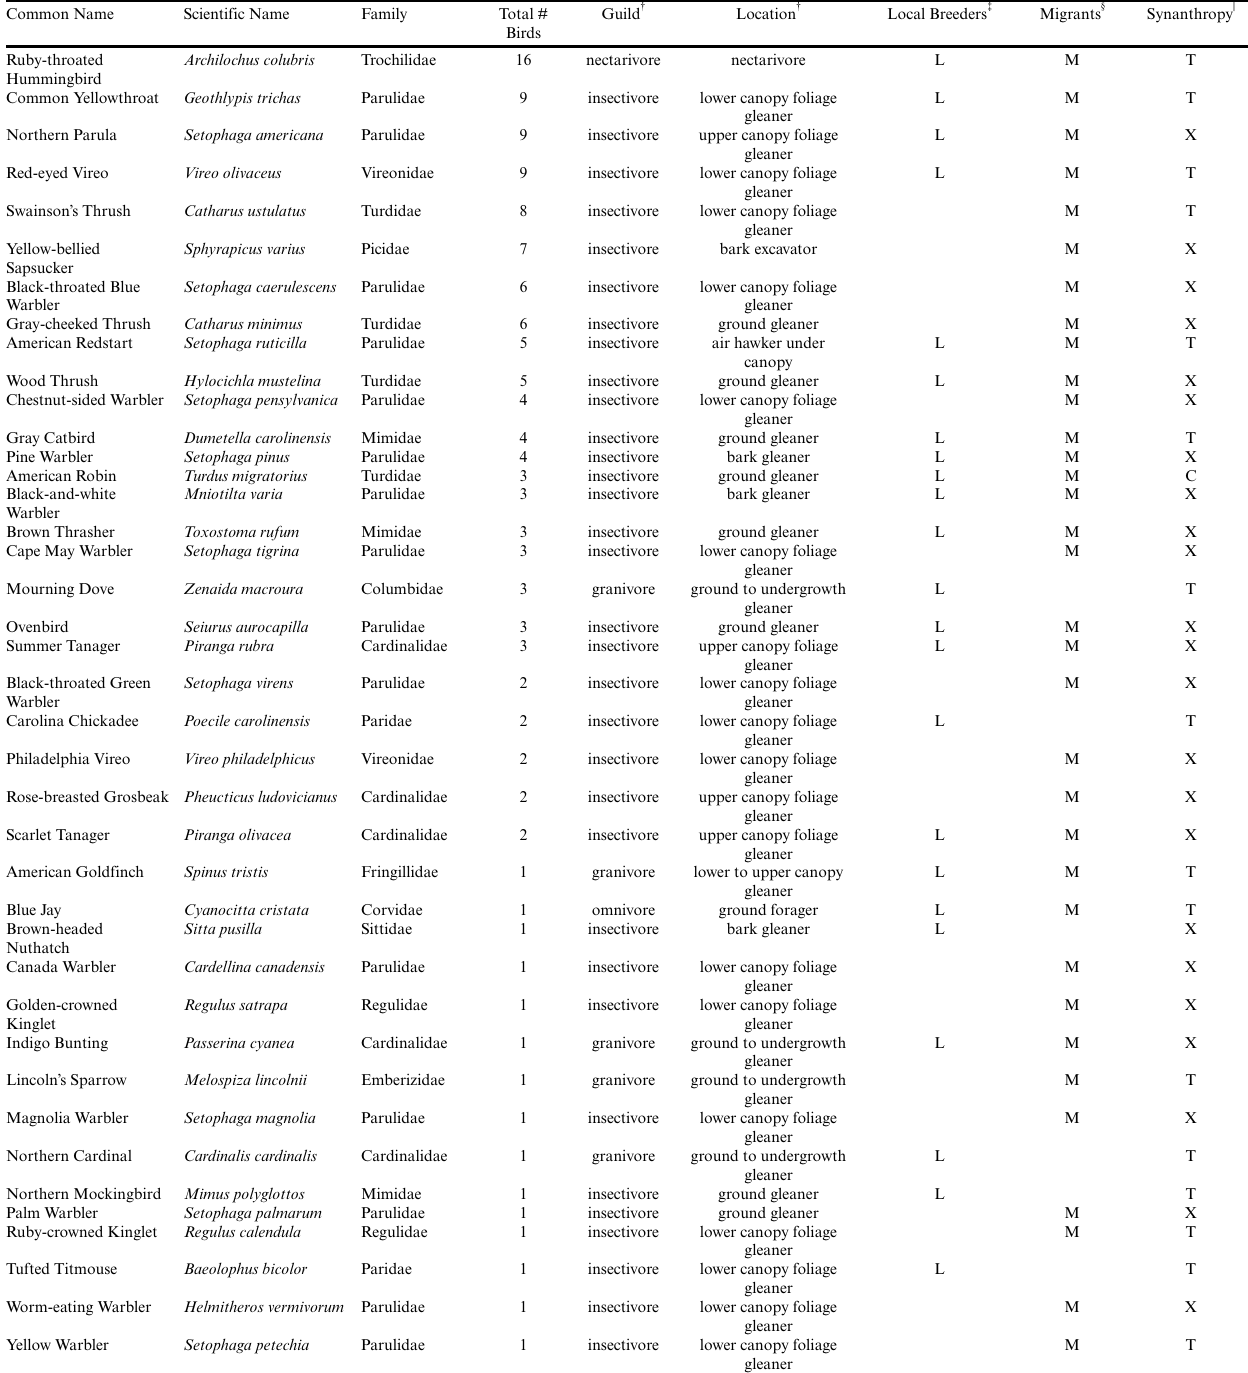
Table 1 . Taxonomic classification, guild, feeding location, synanthropy (SY), local breeding status (LB), and migration status (MG) of birds that collided with windows on the three Triangle campuses from September 18 until October 9,